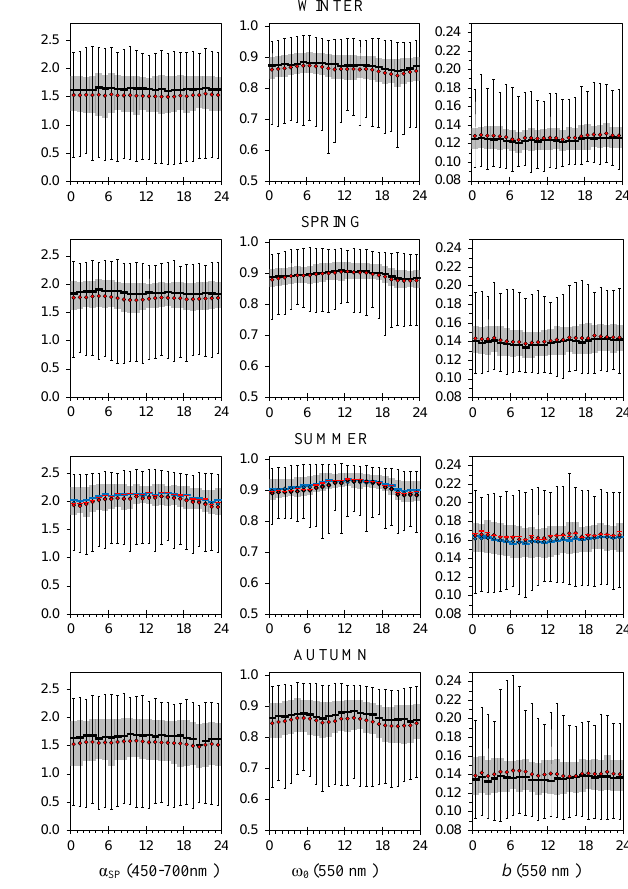
Fig. 7. Diurnal cycle of ˚Angstr¨om exponent of scattering ( α SP ) , single-scattering albedo ( ω 0 ) and backscatter fraction ( b) in four seasons in 13 October 2006–31 May 2009. Red dot: average; black line: median; grey bar: 25th to 75thpercentiles; thin error bar: 2.5th to 97.5thpercentiles. For the summer data the red symbols represent the mean and median of those data where RH NEPH < 50% and the respective blue symbols all data without RH